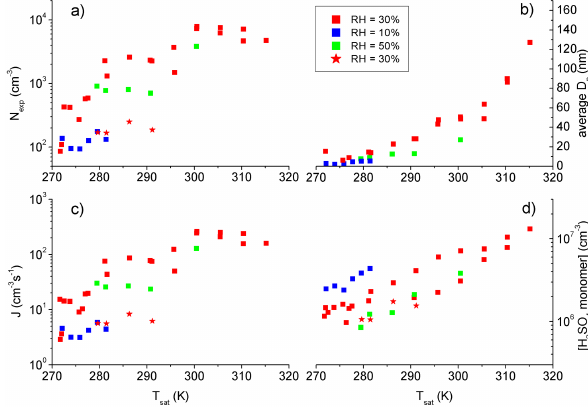
Figure 6. Number concentration N exp (a) measured with PSM and TSI 3776, geometric-mean diameter D p (b) , apparent forma- tion rate J (c) of the freshly nucleated particles and sulfuric-acid monomer concentration measured (d) with CIMS (squares) or CI- Api-TOF (stars) with several relative humidity as a function of satu- rator temperature with saturator flow of 0.1Lpm. All data are aver- aged over a period of constant saturator temperature excluding first hour to ensure steady-state. Stars are measured with CI-Api-TOF and squares with CIMS. All data are averaged over a period of con- stant saturator temperature ( ± 0.05K) extracting the first hour.